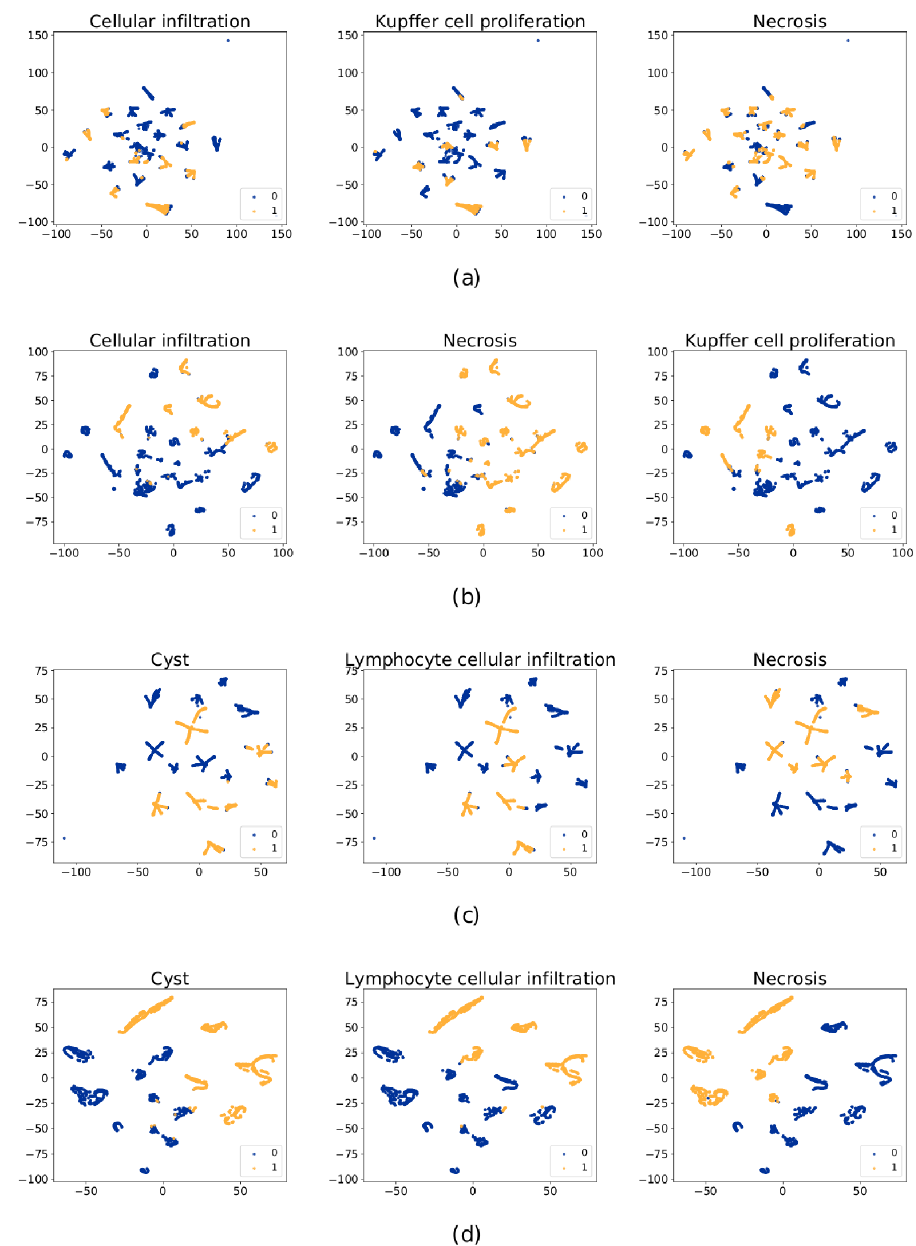
Fig 3. The t-SNE visualization of features for different pathological findings (from one fold). (a) and (b) shows the raw features and features generatedafter RNN layer, respectively. Three pathological findings cellular infiltration, necrosis and kupffer cell proliferation from liver data are involved. (c) and (d) shows the raw featuresand features generated after RNN layer, respectively and three pathological findings cyst, lymphocyte cellular infiltration and necrosis from kidney data are involved. The blue points represent 0 (no findings) and the yellow points represent 1 (with findings). The visualization of all targeted pathological findings using t-SNE can be found in S1 Fig for liver and S2 Fig for kidney. Tables 2 and 3 show the ACC values of the RNN layer of our proposed model in the liver lab and kidney data sets using two algorithms respectively. It can be seen that Att-RethinkNet based on LSTM has higher ACC for the drug test set, and the prediction accuracy of 20 path- lab ological labels is basically more than 97%, which shows that Att-RethinkNet based on LSTM